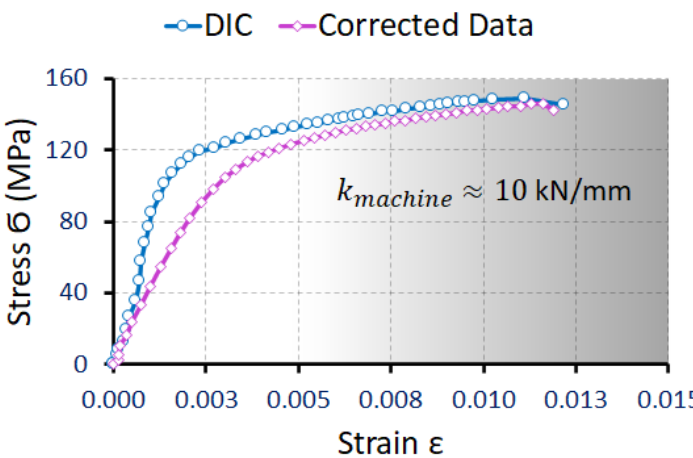
Figure 7. Illustration of sample stress–strain curves obtained from DIC analysis with the testing stage data corrected to account for the testing rig frame compliance.